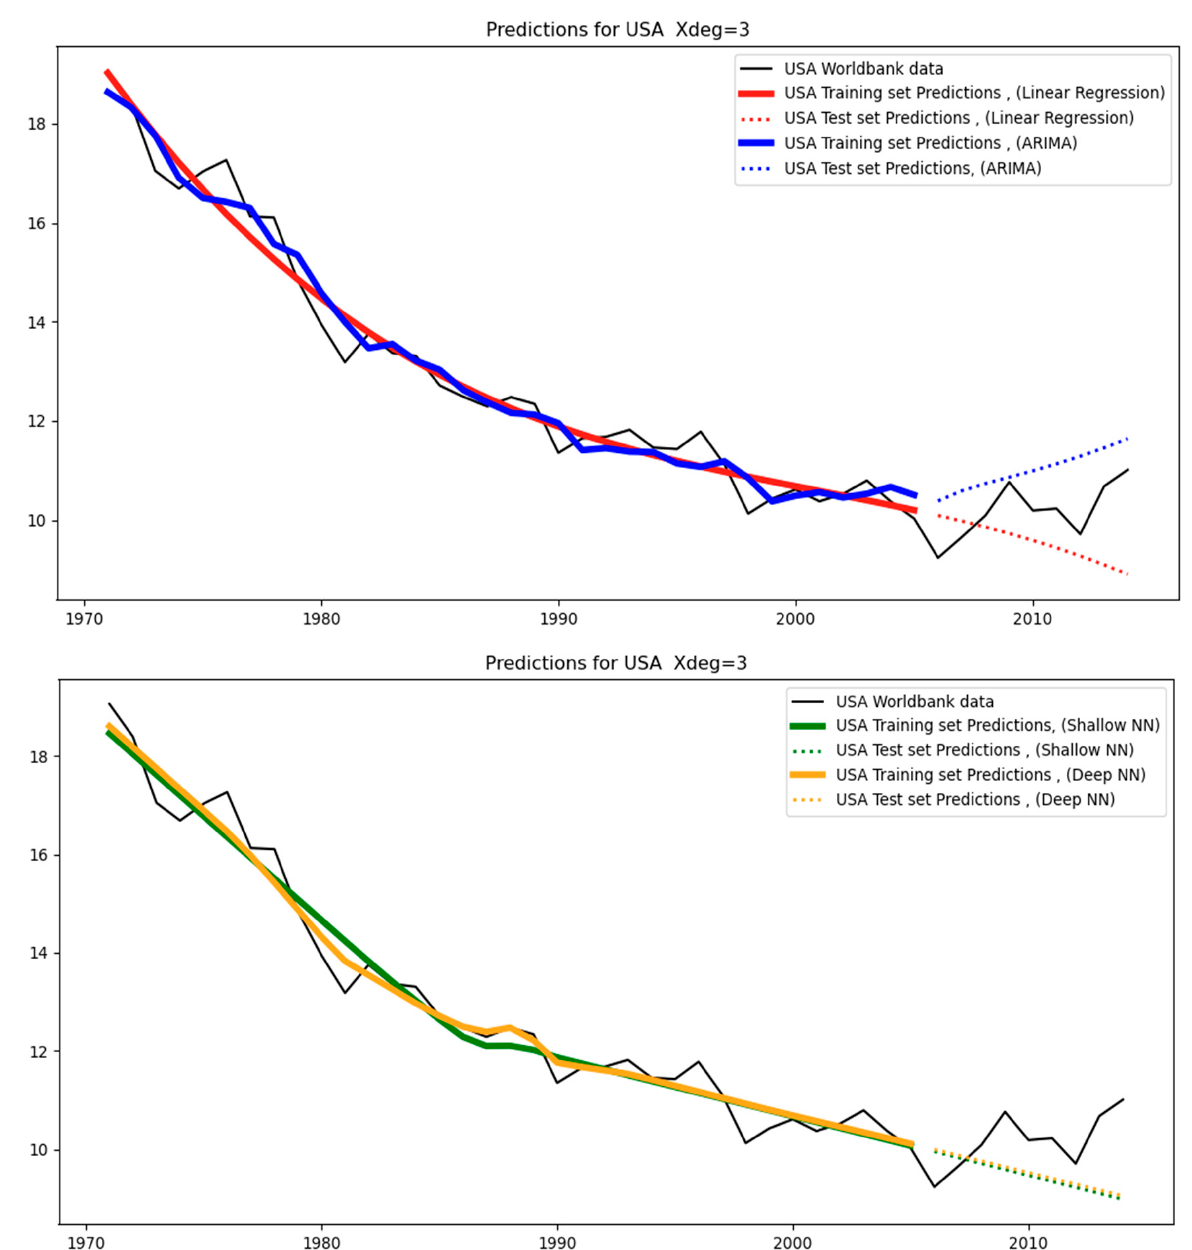
Figure 7. Predictions for the USA, with a third-degree polynomial (Xdeg = 3), are shown for both the training set (periods 1971–2005) and the test set (periods 2006–2014), using linear regression (LR), ARIMA, shallow neural networks, and deep neural network models.